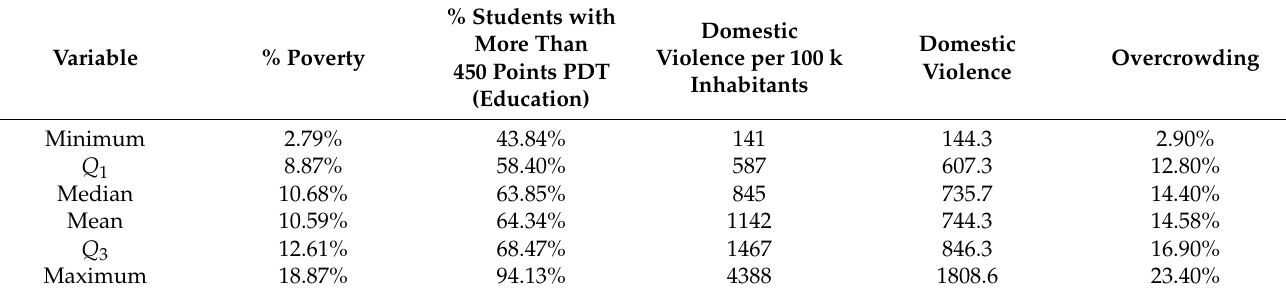
Table 3. Sociodemographic variables summary